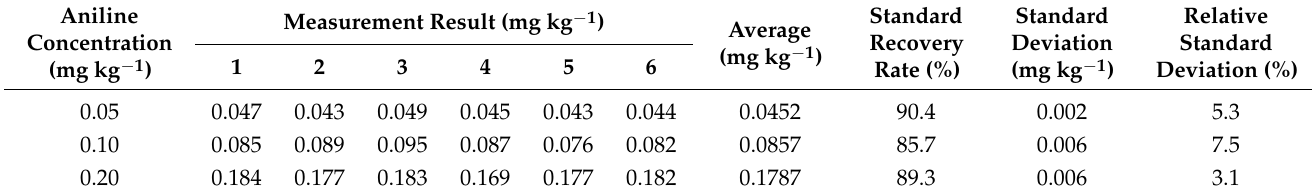
Table 4. The precision and accuracy of the method (inter-day n = 6, on six different days).